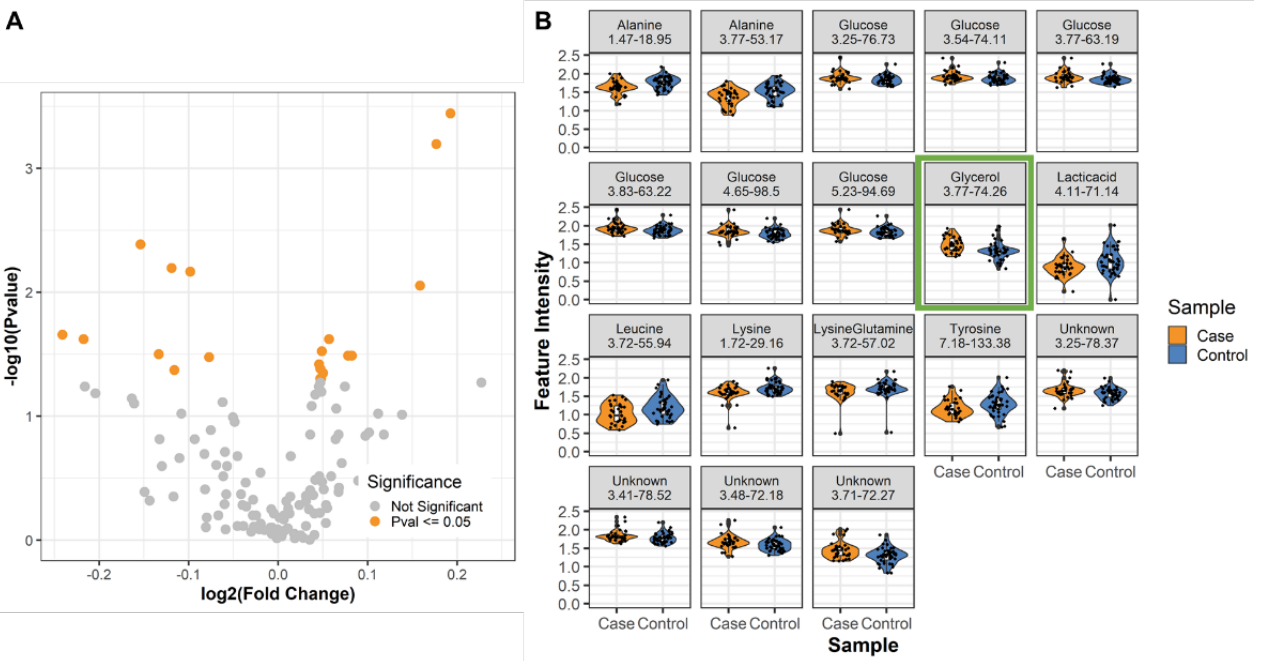
Figure 1. Differential metabolites correlated with male LRRK2 PD. ( A ) Volcano plot of the metabolite resonances extracted from the plasma of male LRRK2 PD patients and non-PD controls, with orange dots indicating significantly different resonances ( p < 0.05). ( B ) Violin plots of the significant resonances identified in ( A ). The resonance at 3.77 and 74.26 ppm in the 1 H and 13 C dimensions indicated by the green box passed the FDR p -value of <0.05.